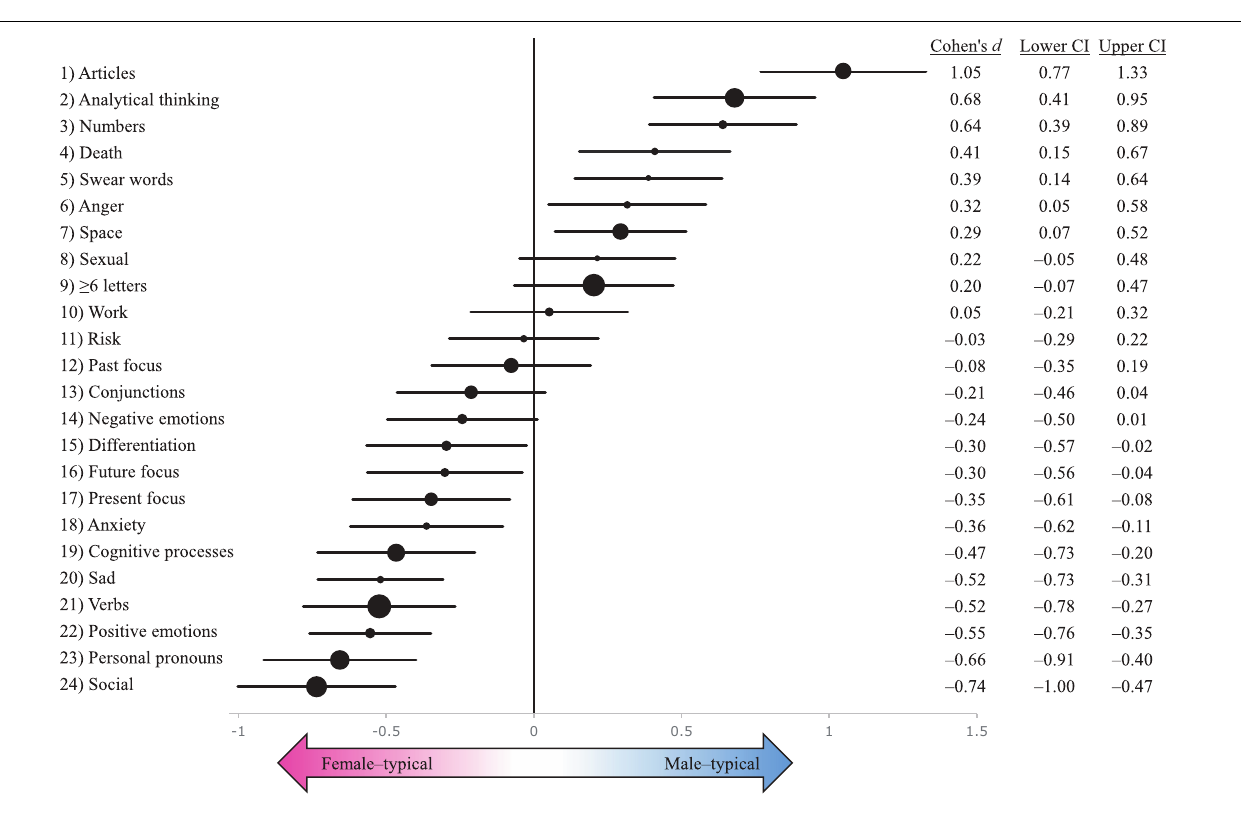
FIGURE 1 | A summary of sex difference effect sizes (Cohen’s d s) with 95% confidence intervals (CI) on 24 psycholinguistic variables. The sample comprised 304 novels by 86 heterosexual male novelists and 85 heterosexual female novelists, published between 1800 and 2018. Cohen’s d s for each psycholinguistic variable are depicted as filled circles, which are scaled to reflect the prevalence of each word category in the overall sample: the larger the circle, the more frequently do words in that category occur in the overall sample. Positive d s represent male advantage; negative d s indicate female advantage. Psycholinguistic categories that are used more frequently by male authors appear on the right side of the figure, and psycholinguistic categories favoured by female authors appear on the left side of the figure. Error bars represent 95% confidence intervals. The effect sizes and CIs are calculated based on a multilevel model which controls for variation in publication year and author’s age at publication ( Supplementary Table 8